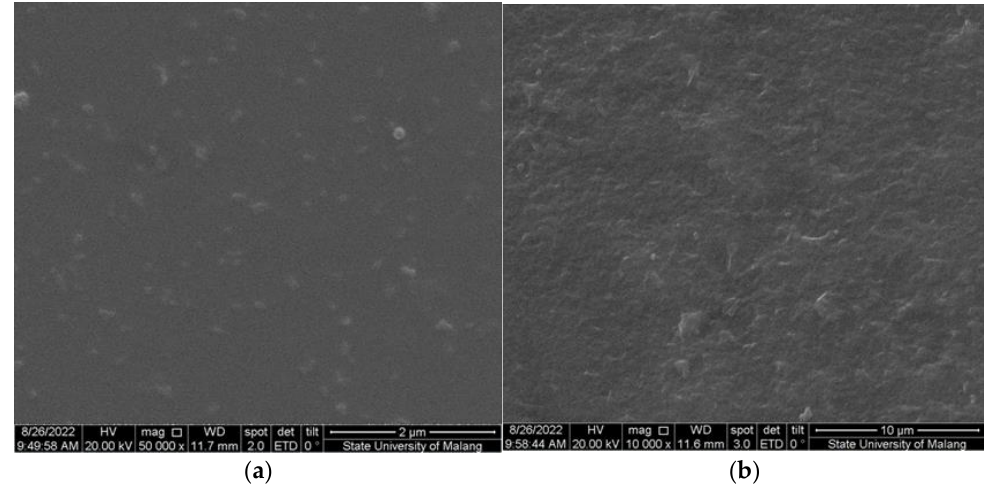
Figure 5. SEM image of the M-4G ( a ) and M-4S ( b ) surfaces.